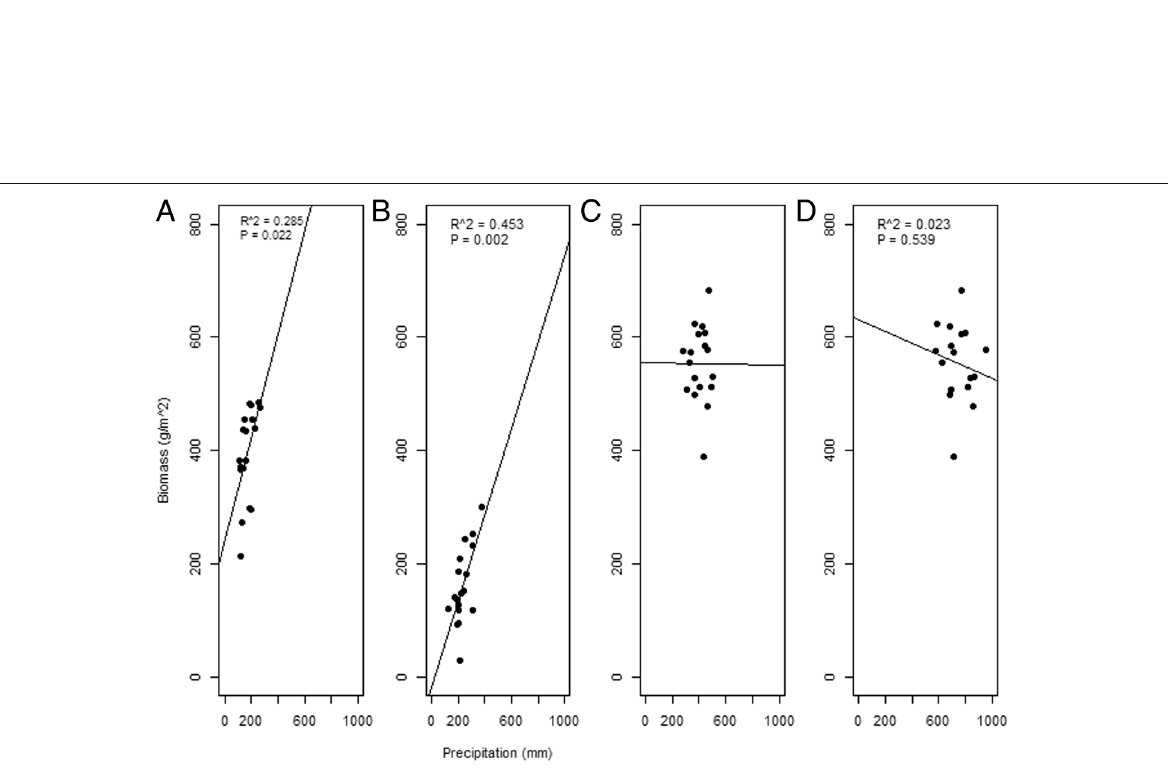
Fig. 6 Response of aboveground biomass productivity to precipitation variability for the study period 1997 – 2015, excluding the extreme event 2003. Relationships of aboveground biomass in June with growing season (March – June) precipitation ( a ), biomass in September with growing season (June – September) precipitation ( b ), annual biomass with growing season (March – September) precipitation ( c ), and annual biomass with annual precipitation ( d